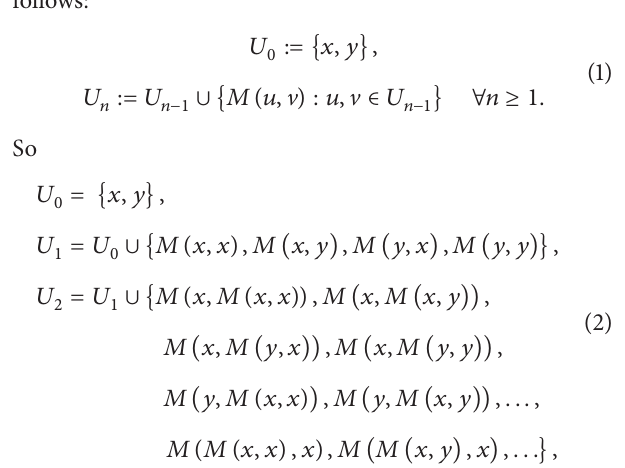
notion of orbit for a given bilinear operator 𝑀 : 𝑋×𝑋 → 𝑋